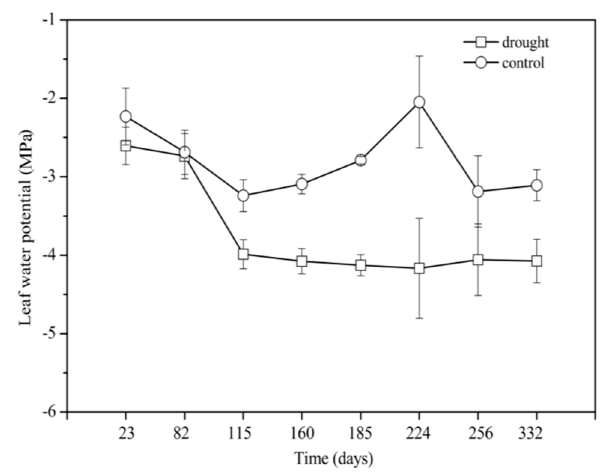
Figure 3. Monthly patterns of dawn leaf water potentials from April 2013 to March 2014.